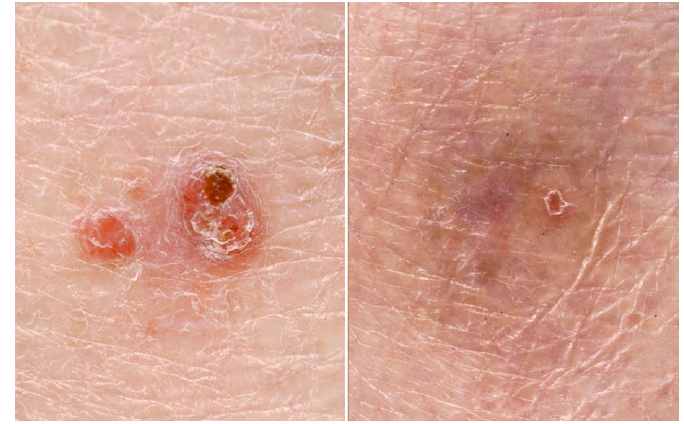
Figure 1. Superficial basal cell carcinoma before and after treatment with photodynamic therapy.